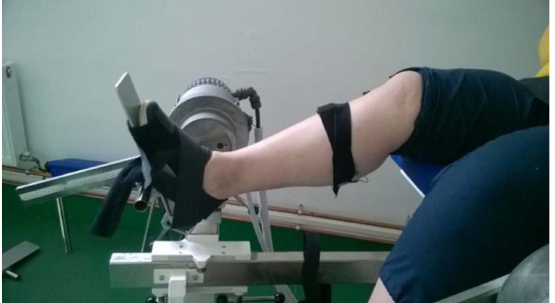
Figure 2. Foot position for testing MVIC plantar- and dorsiflexion on Multicont II isokinetic